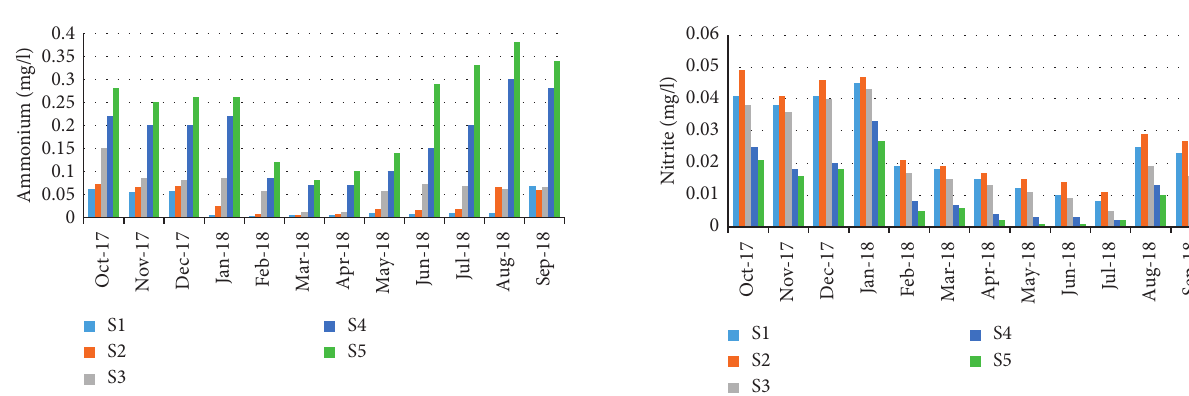
Figure 12: Spatial-temporal variation of nitrite in the Zegzel watercourse.